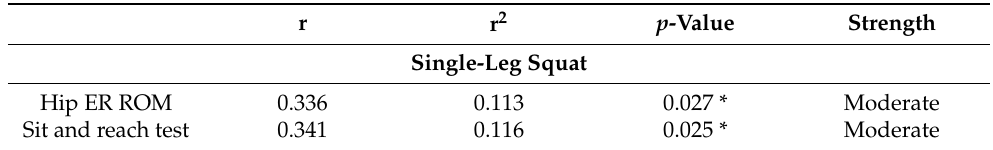
Table 5. Linear regression model with Pearson’s correlation between the dominant leg SLHD and dominant leg YBT. r r 2 p -Value Strength Single-Leg Squat Hip ER ROM 0.336 0.113 0.027 * Moderate Sit and reach test 0.341 0.116 0.025 *